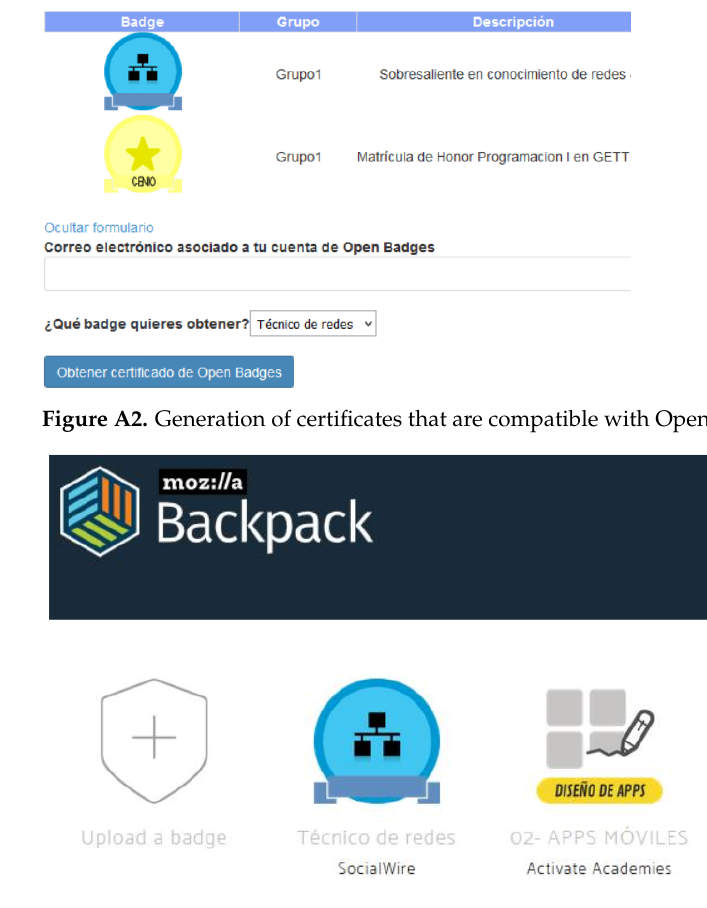
Figure A3. List of badges in Mozilla